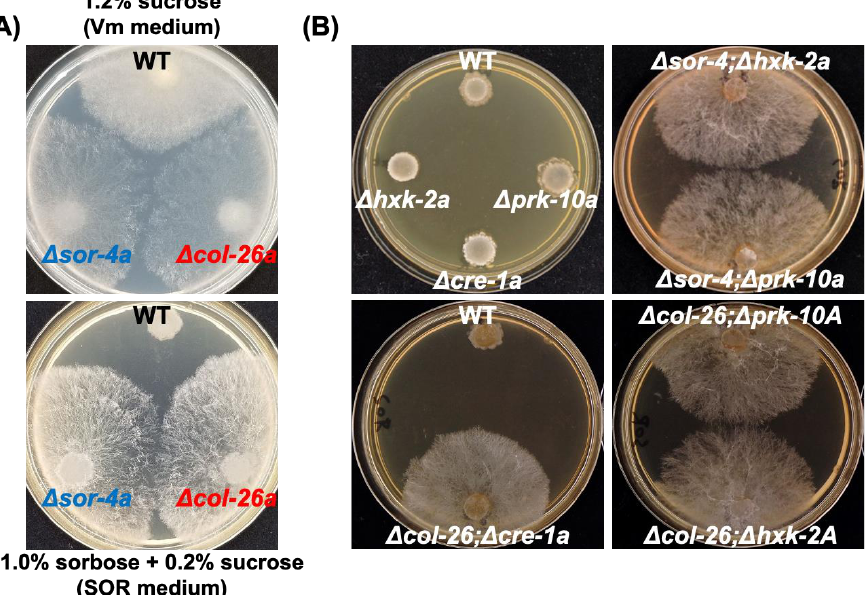
Figure 1. Sorbose resistance of deletion mutants of sor -4 and col -26 gene, and their double mutant, with the factors involved in carbon catabolite repression. ( A ) Sorbose resistance of sor -4 and col -26 mutants. Conidia suspensions of wild type, ∆ sor -4 a , and ∆ col -26 a strains were inoculated and cultured on Vogel’s minimal medium containing 1.2% sucrose (Vm medium, top panel) for 2 days, and on Vogel’s minimal medium containing 1% sorbose and 0.2% sucrose ( sor medium, bottom panel) for 4 days. Both Δ sor-4a and Δ col-26a displayed filamentous growth on SOR medium. ( B ) Sorbose resistance in mutants of carbon catabolite repression and their double deletion mutants with col-26 or sor-4 mutant. The deletion mutants of hxk-2 (hexokinase), prk-10 (AMPK protein kinase), and cre-1 (transcriptional repressor) genes did not possess sorbose resistance on SOR medium, but their double mutants with sor-4 or col-26 deletion were sorbose-resistant.